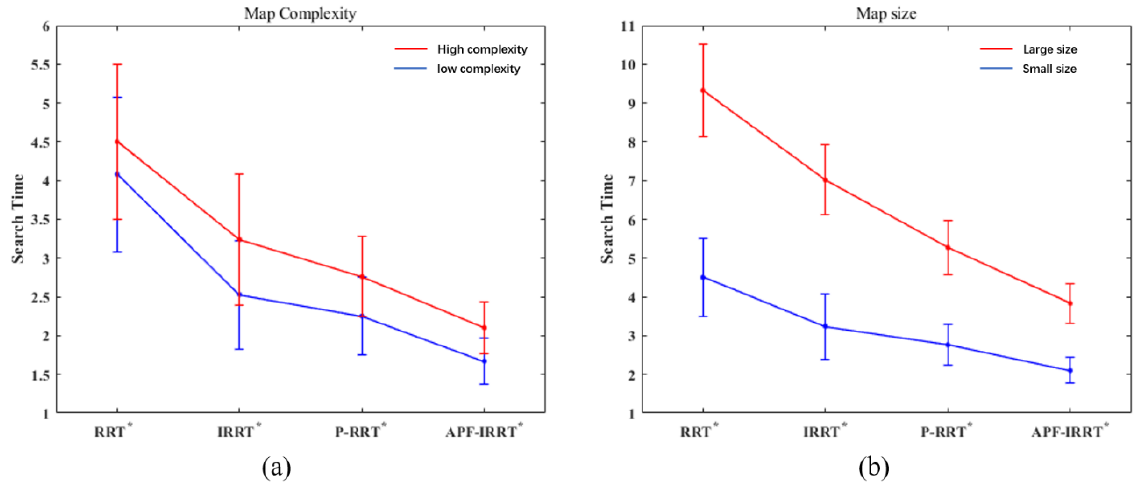
Figure 10. The effect of complexity and size of grid map in search time of four algorithms. ( a ) shows the effect of two different complexity grid maps in search time of four algorithms. The red and blue curves are test environment M5 and M2, respectively. ( b ) shows the effect of two different area grid maps in the search time of four algorithms. The red and blue curves are relatively larger area map and smaller area map, respectively.